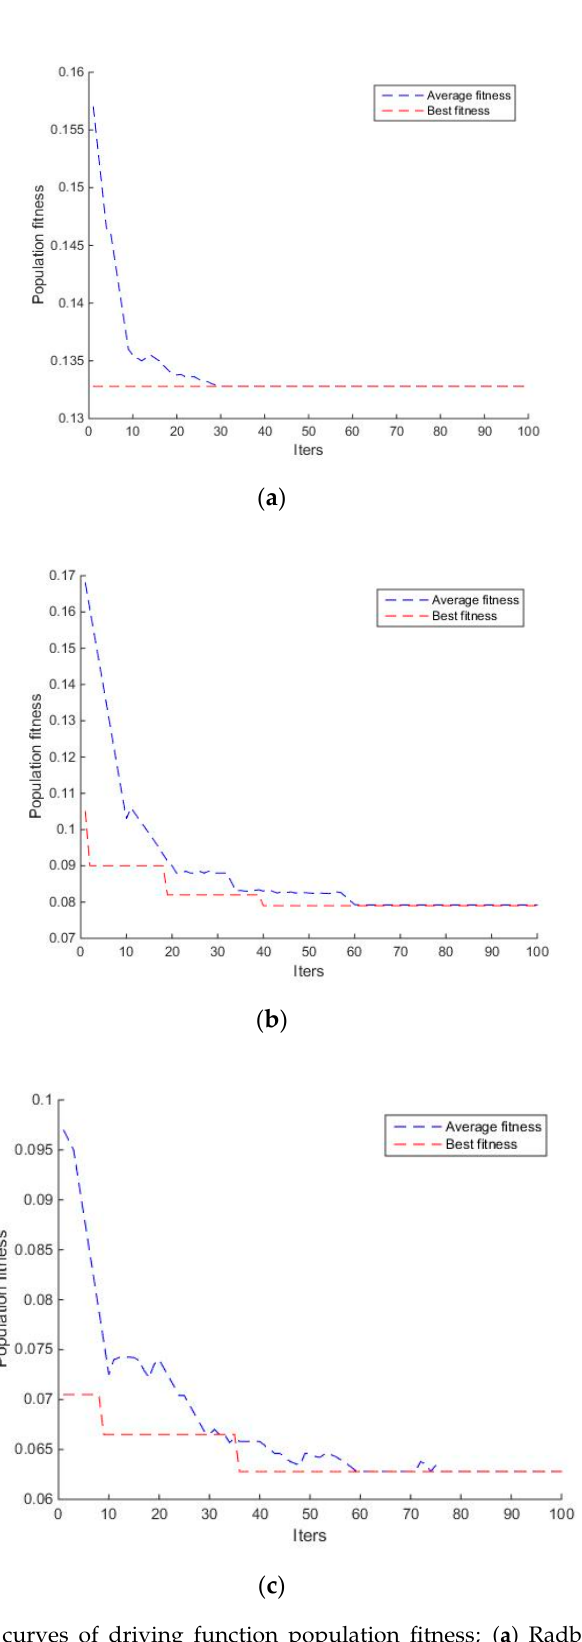
Figure 6. Variation curves of driving function population fitness; ( a ) Radbas driving function; ( b ) Hardlim driving function; ( c ) Sigmoid driving function.